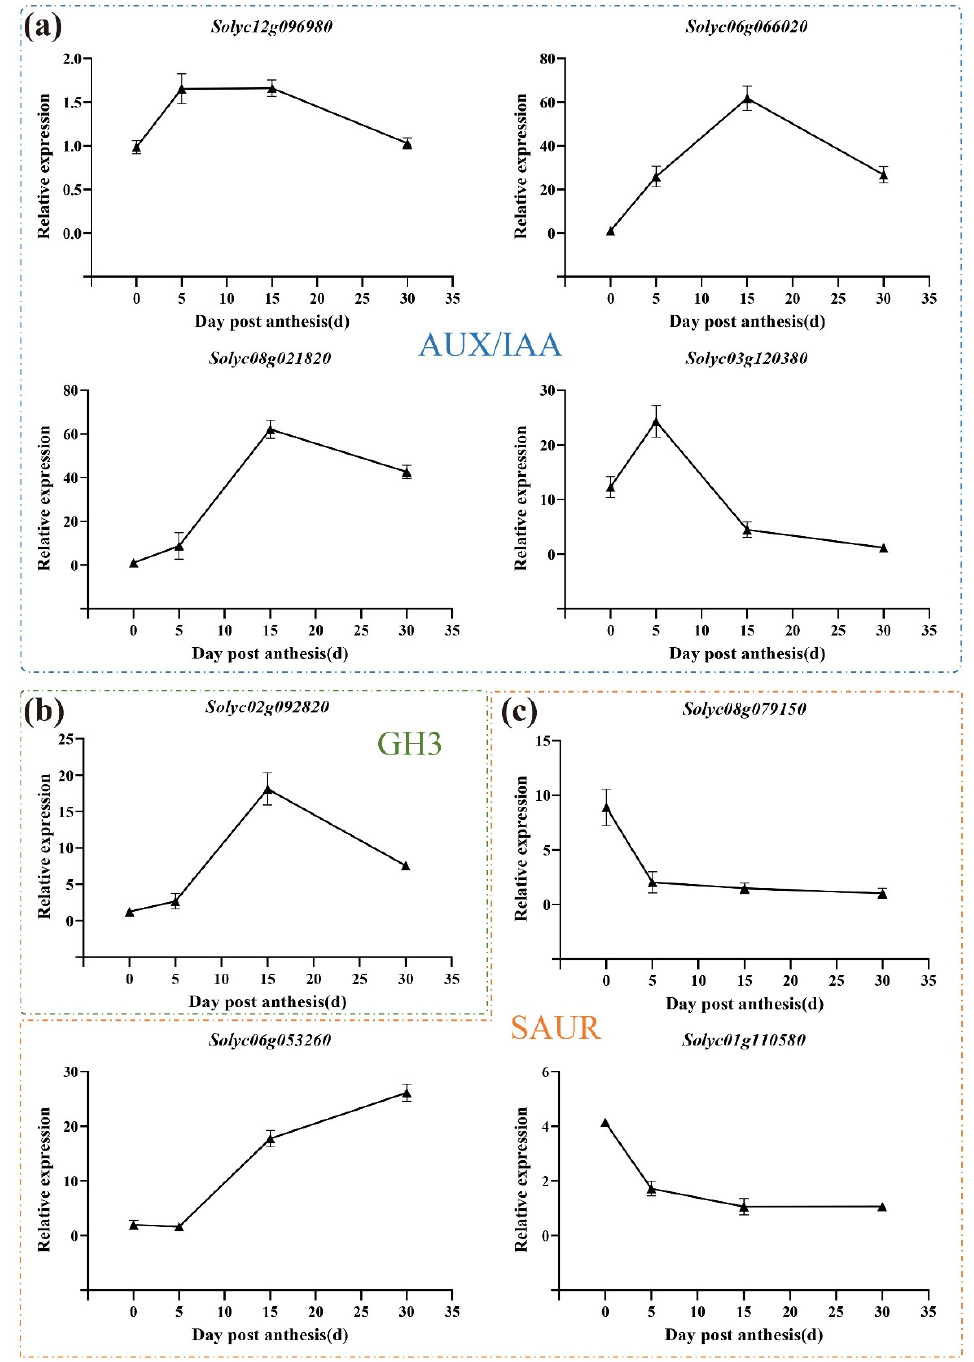
Figure 7. The relative expression of auxin-related genes at different developmental stages. ( a ) The blue box indicates the genes belonging to the AUX/IAA family. ( b ) The green box indicates the genes belonging to the GH3 family. ( c ) The orange box indicates the genes belonging to the SAUR family.